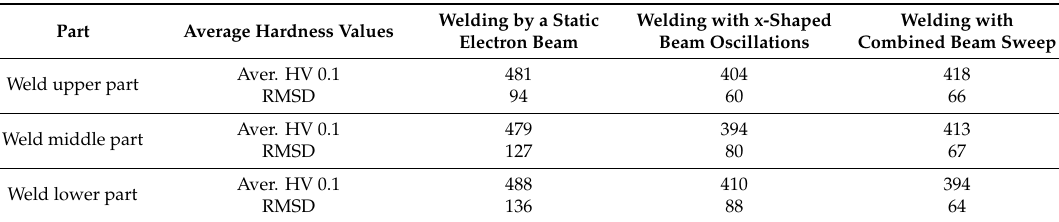
Table 4. Changes in weld metal hardness for di ff erent types of EBW.